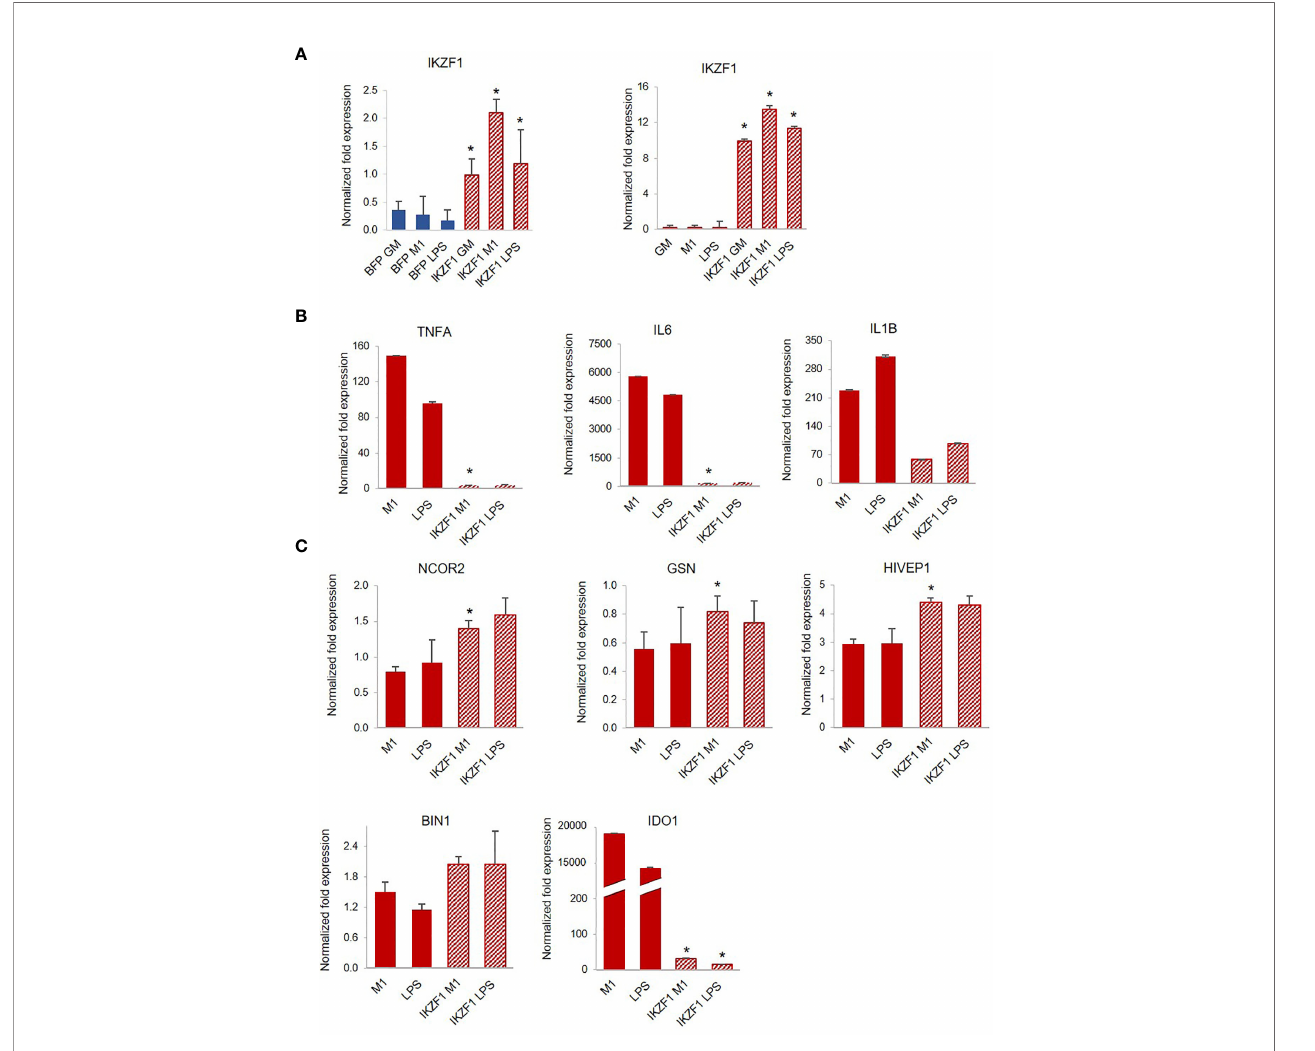
FIGURE 5 | Transfection of IKZF1 into PLWH-MDMs reduces their hyper-responsiveness to LPS and partially restores the expression of negative regulators of in fl ammation. (A) Relative expression of IKZF1 mRNA in IKZF1-transfected PLWH-MDMs (left panel, n=4) at day 3 or day 5 post-isolation (right panel, n=4) in the indicated treatments calculated over T0. BFP control vector or untransfected cells were used as negative controls at day 3 or day 5, respectively. Expression levels of pro-in fl ammatory cytokines TNFA , IL6 , and IL1B (B) and negative regulators of in fl ammation NCOR2 , GSN , HIVEP1 , BIN1 , and IDO1 (C) in cells transfected at day 5 post-isolation (See Figure S1 for data obtained after transfection at day 3). In all graphs, error bars indicate SEM; *indicates statistical signi fi cance between